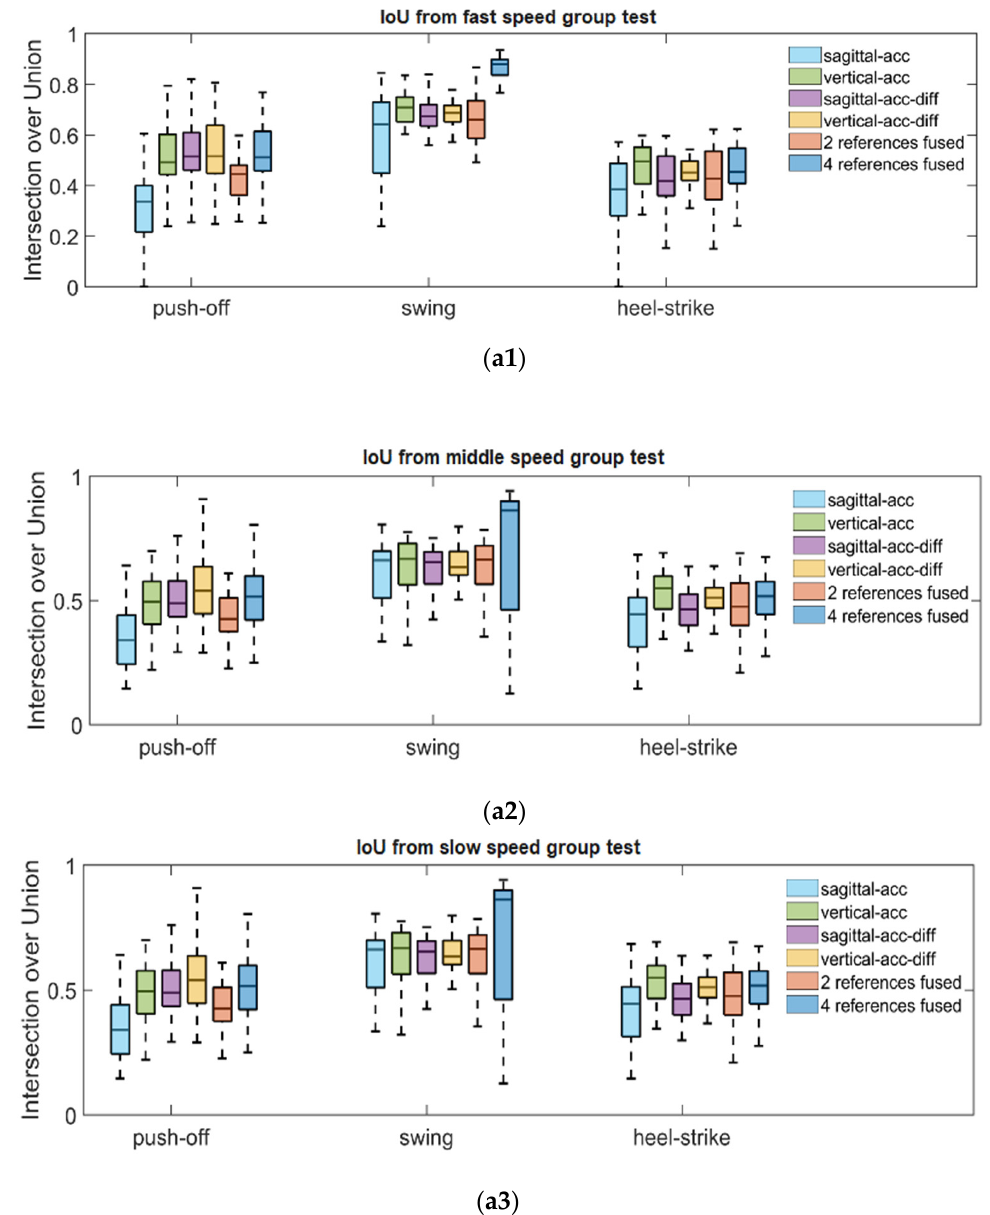
Figure 10. Use IoU as a metric to measure the performance of gait segmentation methods for recog- nizing push-off phases, swing phases, and heel-strike phases. Subfigures ( a1 , a2 , a3 ) show the F-score corresponding to three gait phases in walking with fast speed, middle speed, and slow speed, re- spectively.